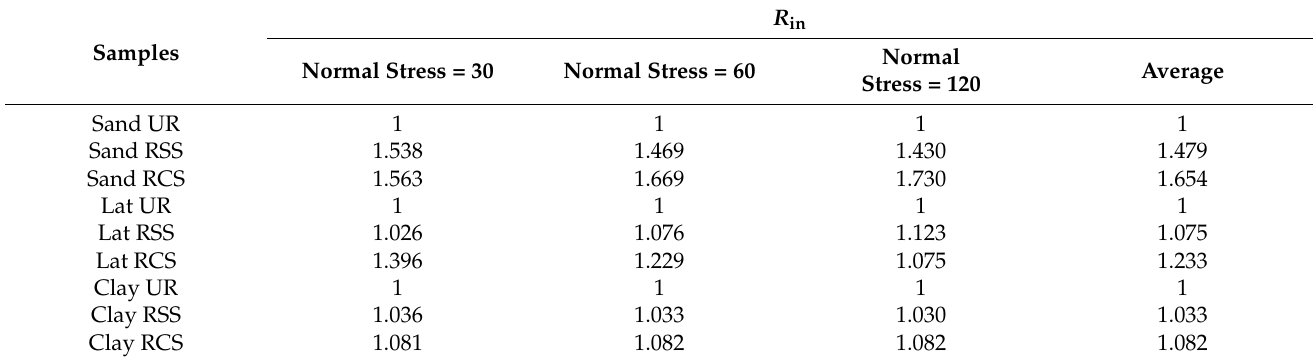
Table 5. The average R in for all testing